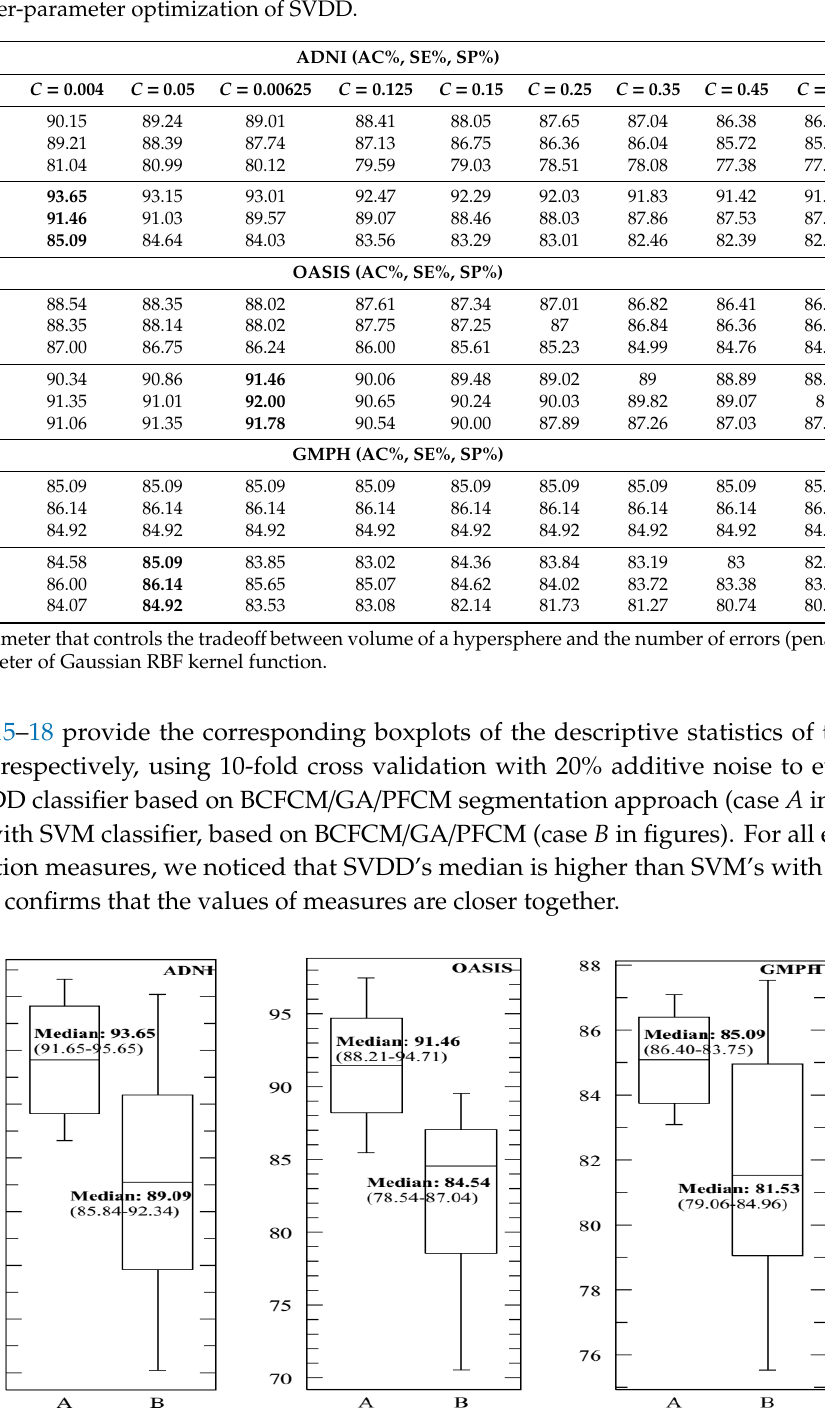
Table 2. Performance results of support vector data description (SVDD) classifier in terms of accuracy (AC)%, sensitivity(SE)% and specificity (SP)% using 10-fold cross-validation and grid search to perform ( σ , C ) hyper-parameter optimization of SVDD.